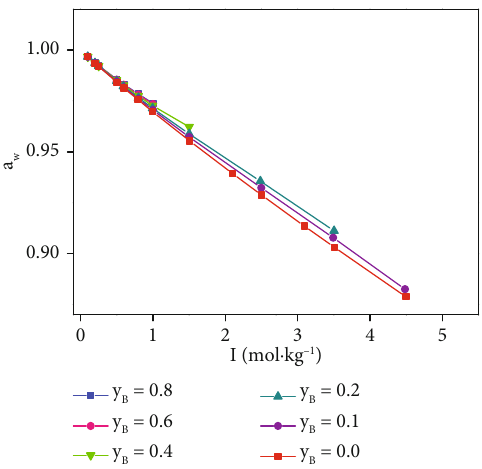
Figure 5: A plot of water activities against ionic strengths in the ternary system.